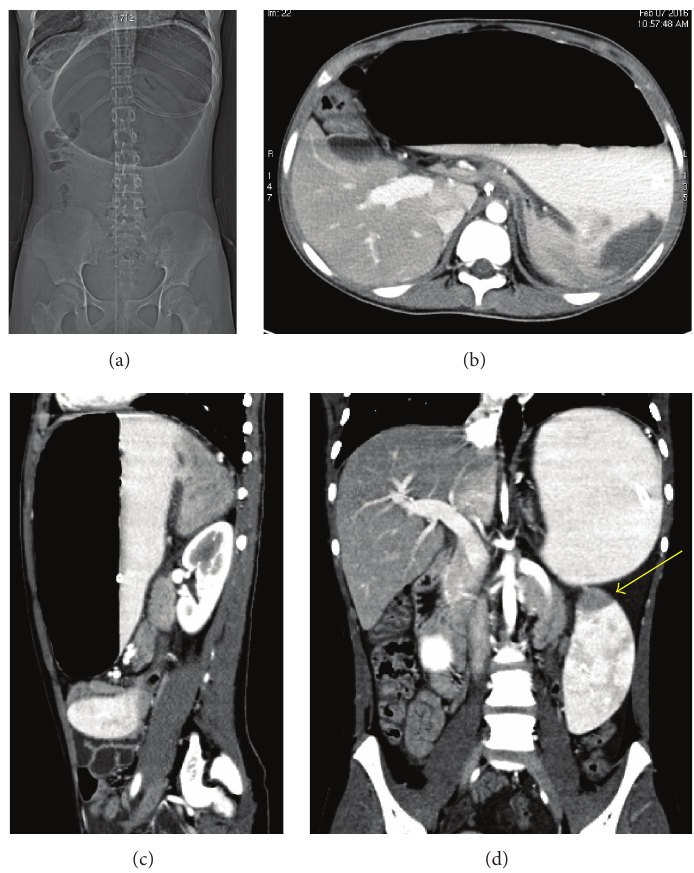
Figure 3: CT scan with oral and intravenous contrast. CT scanogram (a), axial CT scan (b), and sagittal reconstruction (c) show the contrast- filled distended stomach, due to an organoaxial gastric volvulus. The coronal reconstruction (d) reveals a displaced spleen with hypoperfusion of the upper pole (yellow arrow).